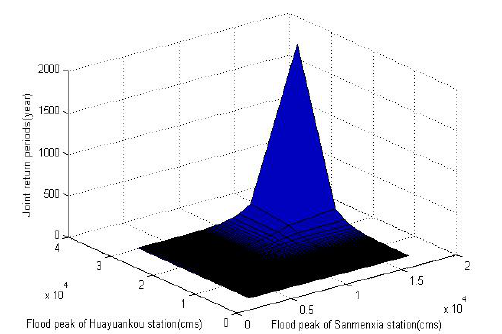
Fig. 8. Joint return periods of AMFMs of Sanmenxia